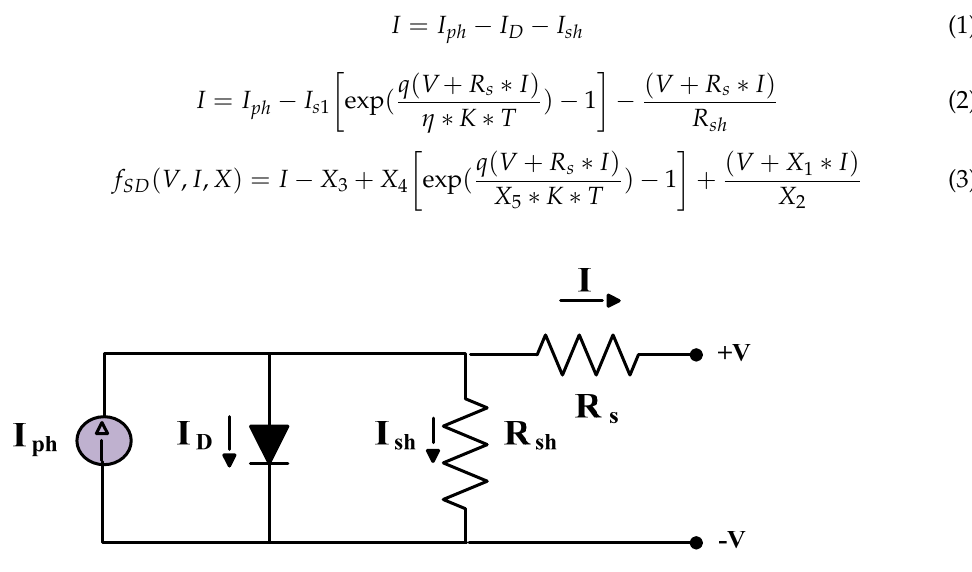
Figure 1. The SDM. Figure 1. The SDM.